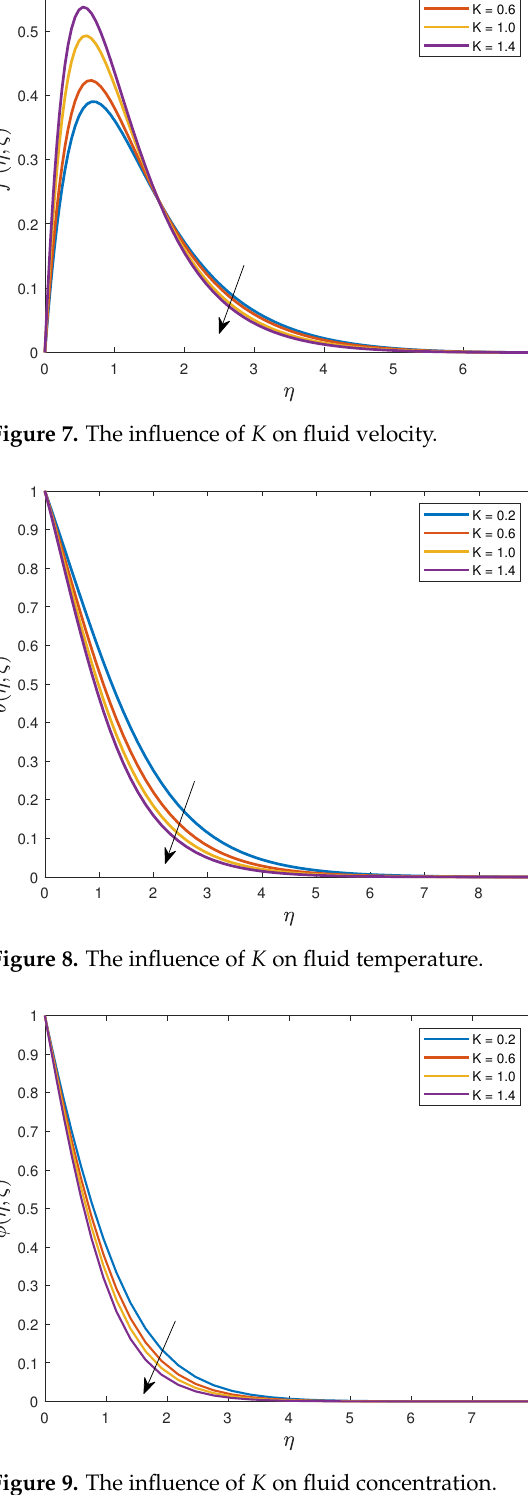
Figure 9. The influence of K on fluid